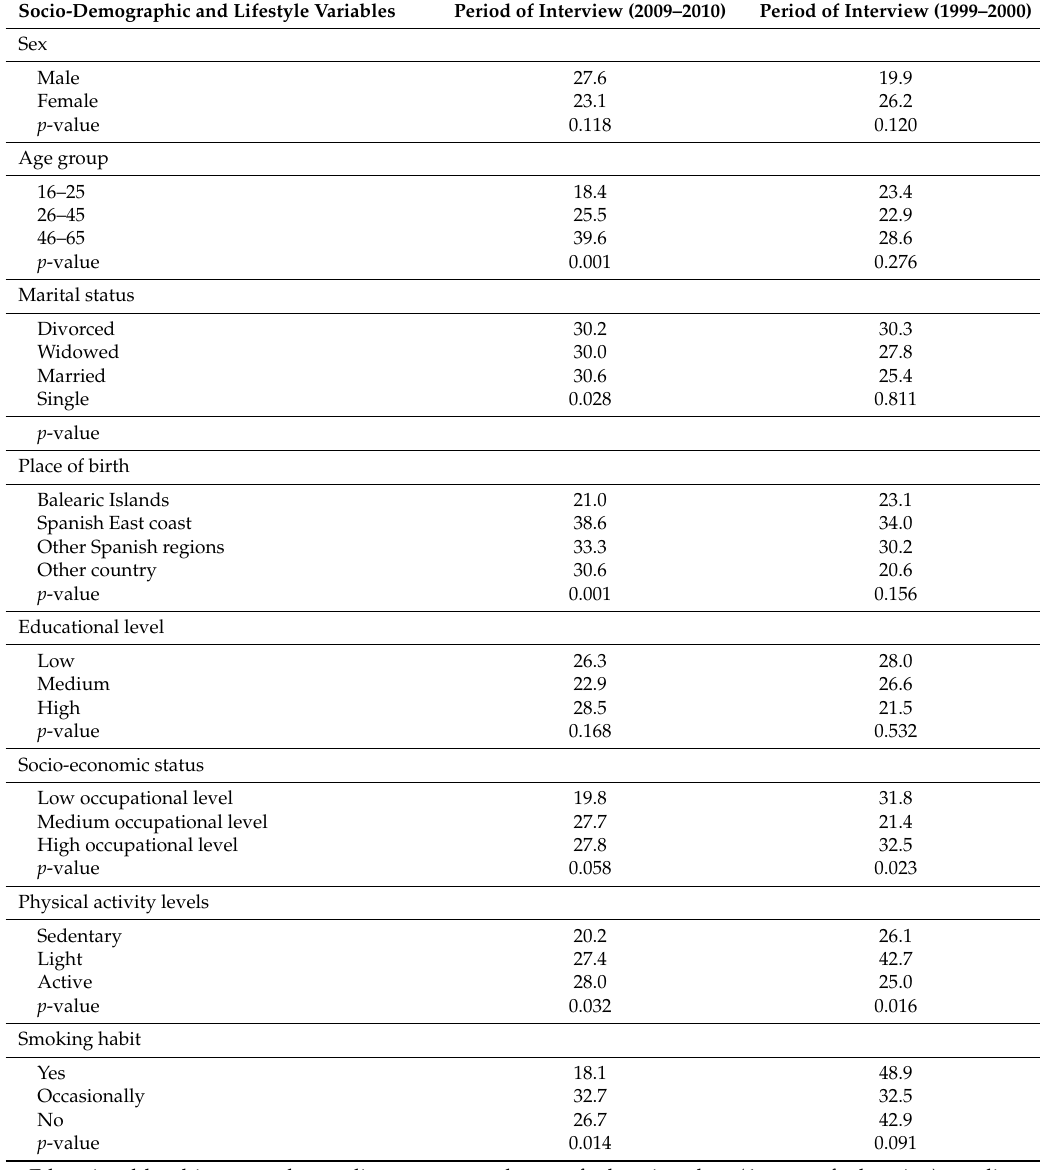
Table 1. Percentage of high adherent participants to the Mediterranean dietary pattern (MDP) (quartile 4) according to period of interview and selected socio-demographic and lifestyle